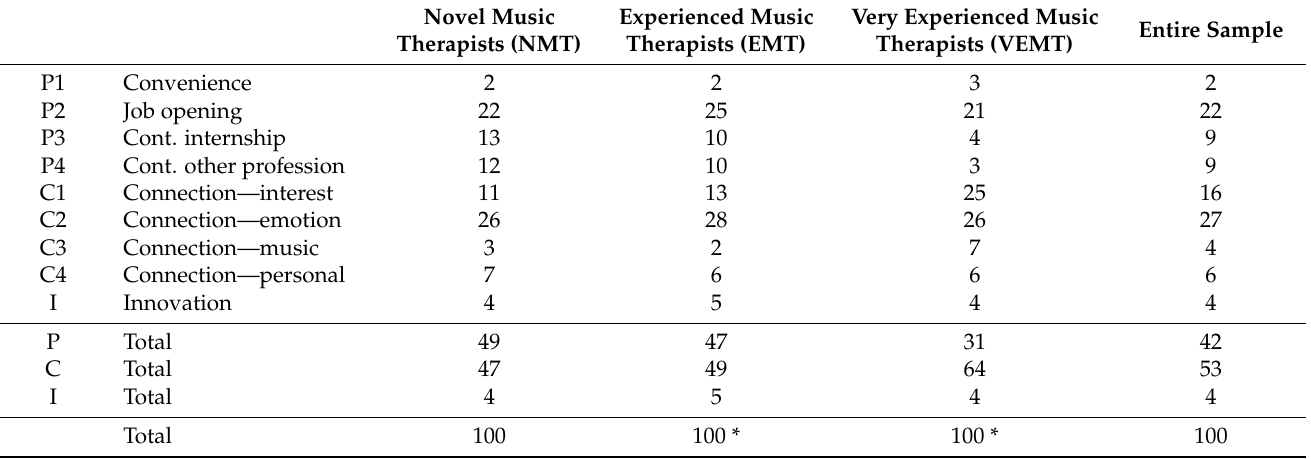
Table 4. Percentage of times that different reasons for working with clientele were mentioned: cate- gories, subcategories in entire sample and according to work experience (novel, experienced, and very experienced music